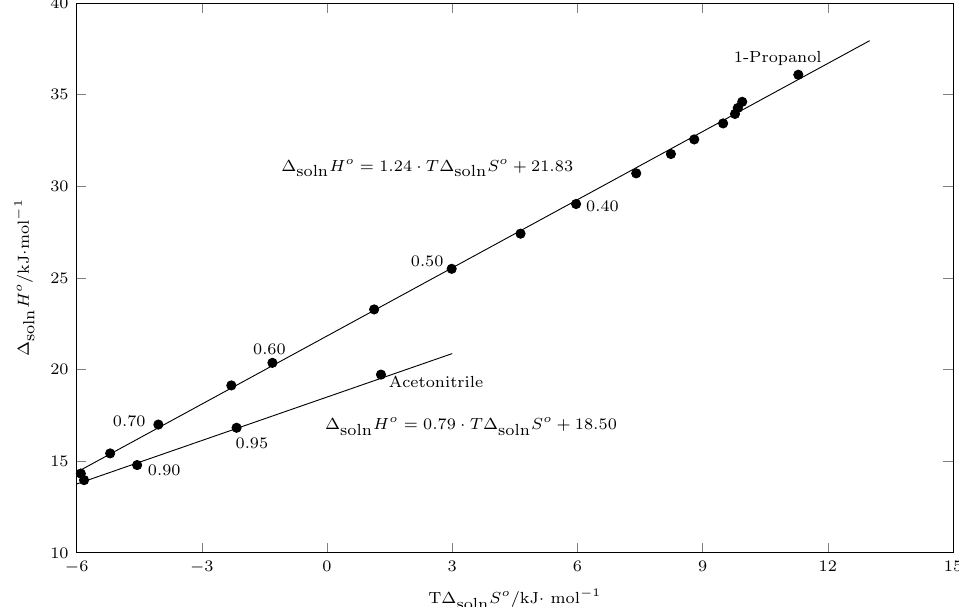
Figure 5. Enthalpy–entropy compensation plot for the solubility of SD (3) in {MeCN(1) + 1-PrOH(2)} mixtures at T hm = 297.6